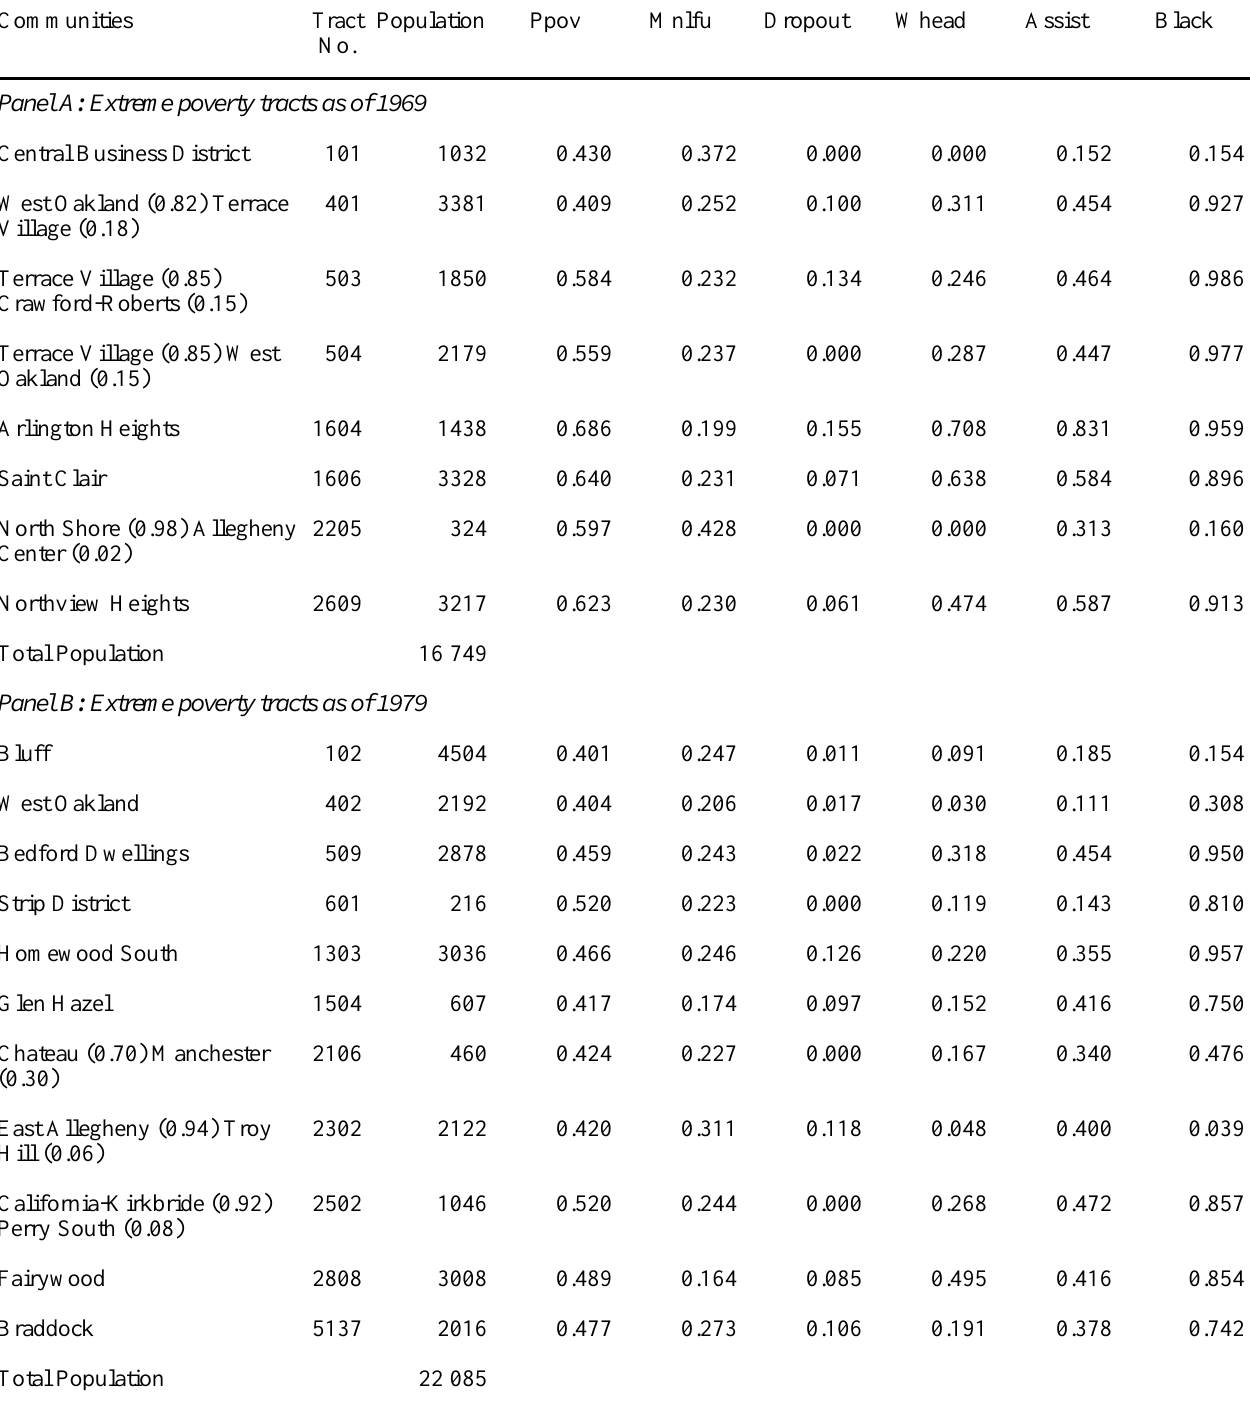
Table 9. Extreme poverty tracts in 1979, Pittsburgh Standard Metropolitan Statistical Area Communities Tract Population Ppov Mnlfu Dropout Whead Assist Black No. Panel A: Extreme poverty tracts as of 1969 Central Business District 101 1032 0.430 0.372